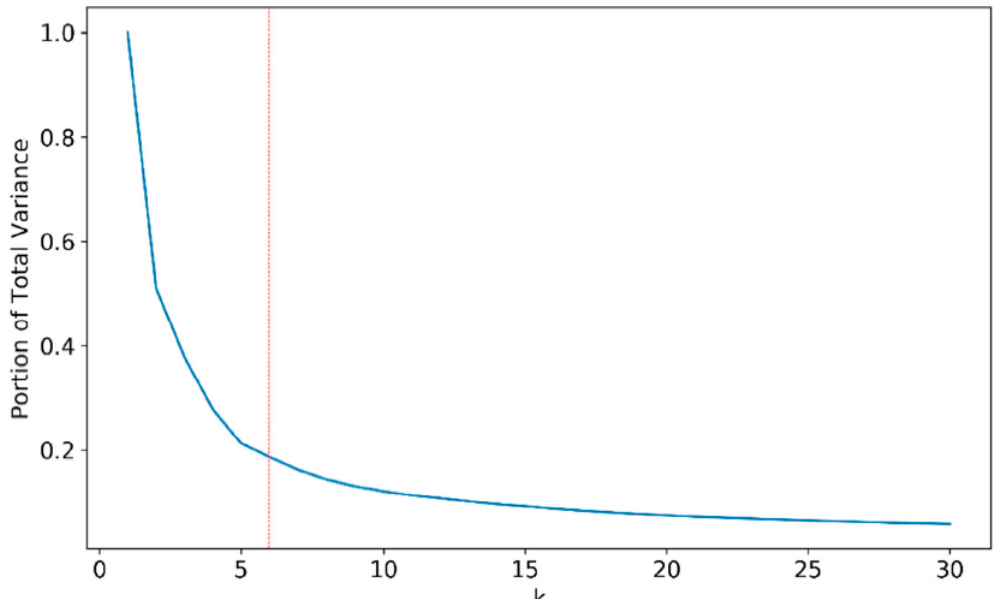
Figure 2. Variance as a function of the number of clusters (k) used in the k-means clustering, expressed as a portion of the total variance of the dataset. The red vertical line represents the number of clusters chosen for